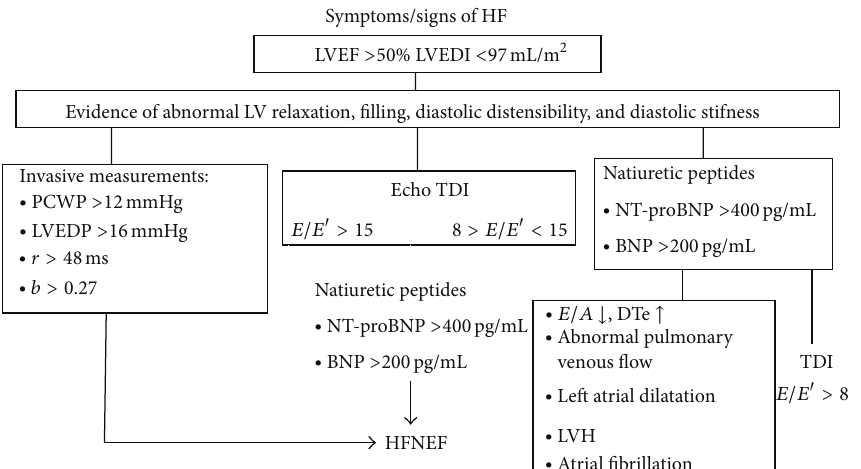
Figure 2: Algorithm including both echo and NP measurements to identify patients with HF and preserved systolic function (modified by Maeder and Kaye